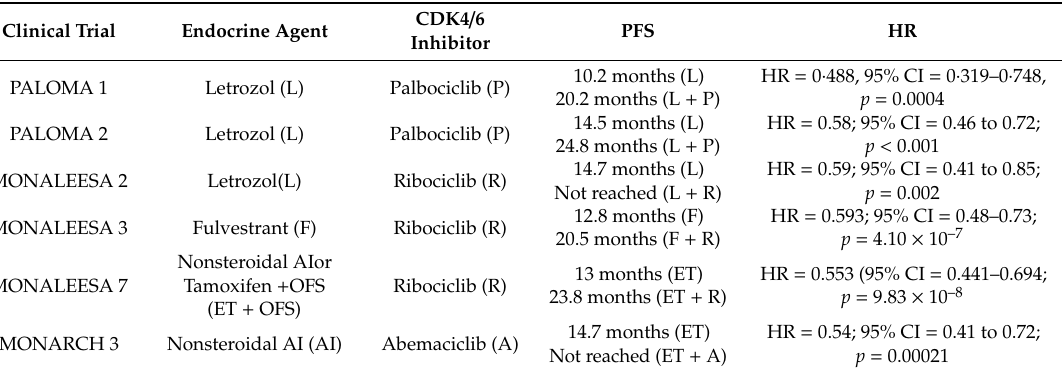
Table 1. CDK4 / 6 inhibitors in the first-line